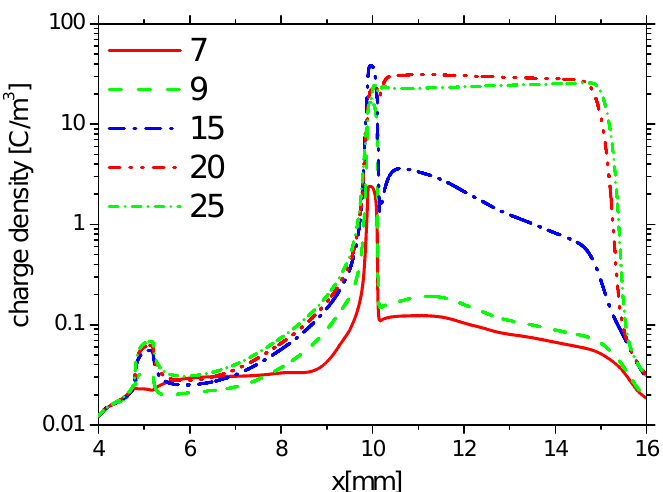
Figure 5. The distributions of charge density on the wall at time 7 ns, 9 ns, 15 ns, 20 ns, and 25 ns in the rise phase in Case 1.